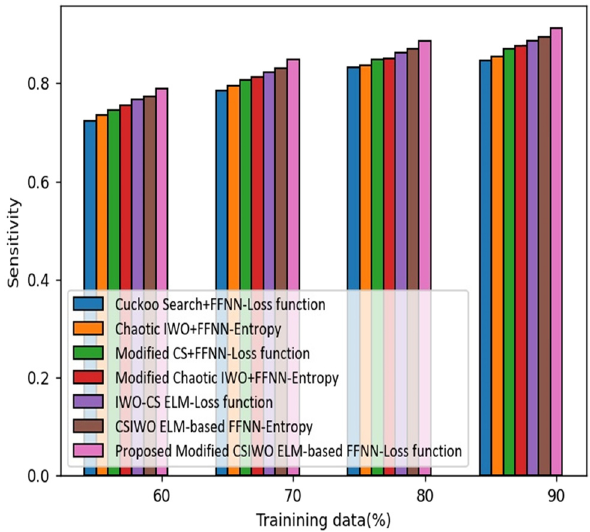
Figure 6: Analysis based on objective value function - based